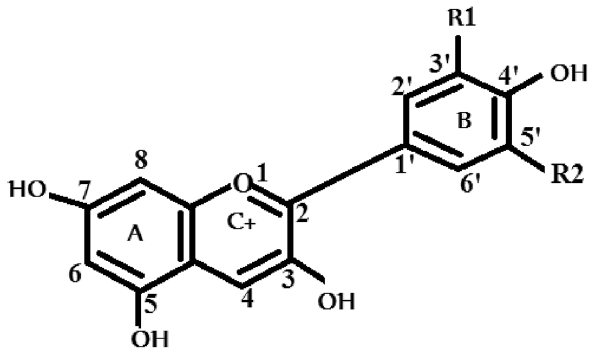
Fig. 1 General structure of anthocyanin: a aromatic hydrocarbon, b aromatic hydrocarbon, heterocyclic ring ( c